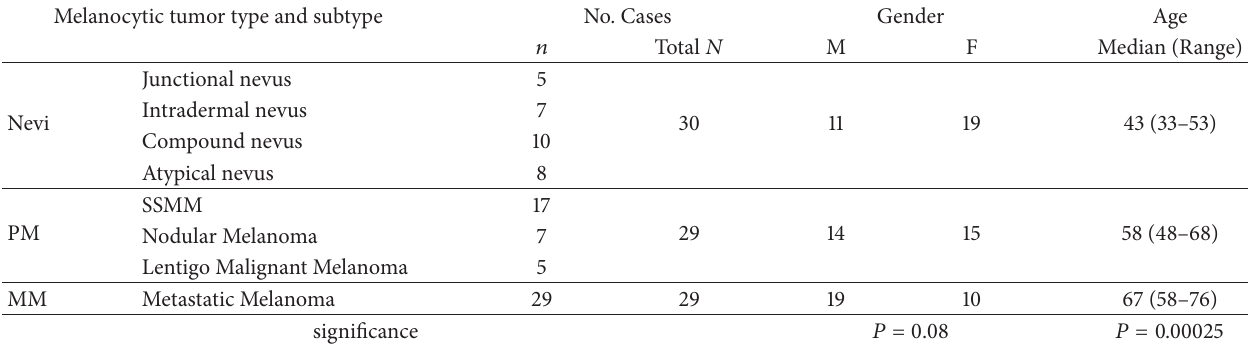
Table 1: Association of melanocytic nevi and melanoma with demographic characteristics of the patients. Melanocytic tumor type and subtype